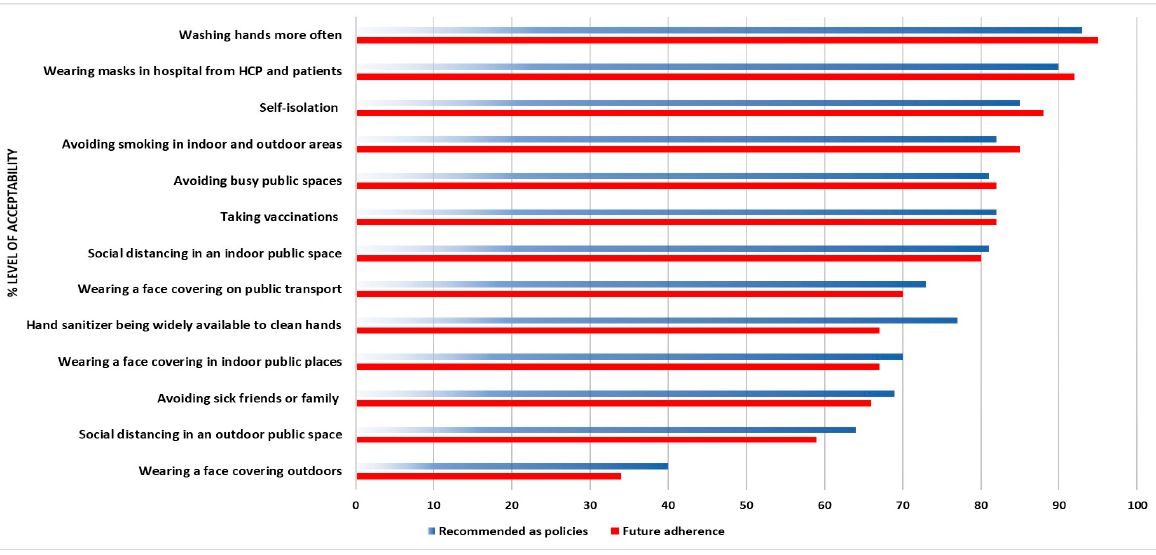
Figure 4. The acceptability of respiratory virus infection control interventions in people with chronic respiratory disease, including if there will be policies in the future or not.